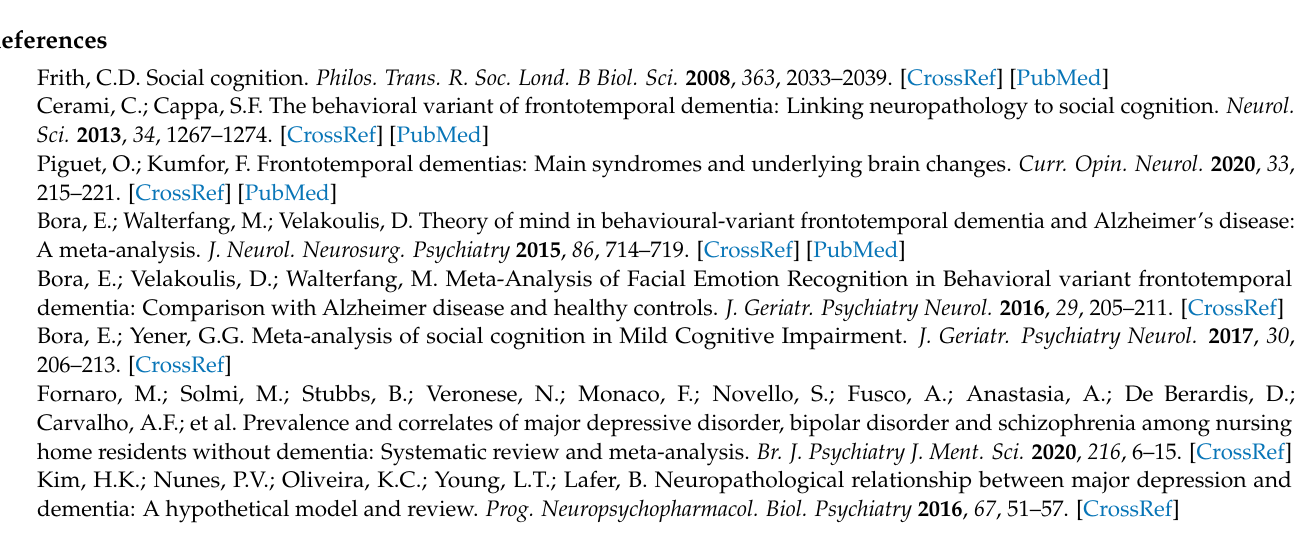
Table S2. PRISMA guideline for reporting systematic